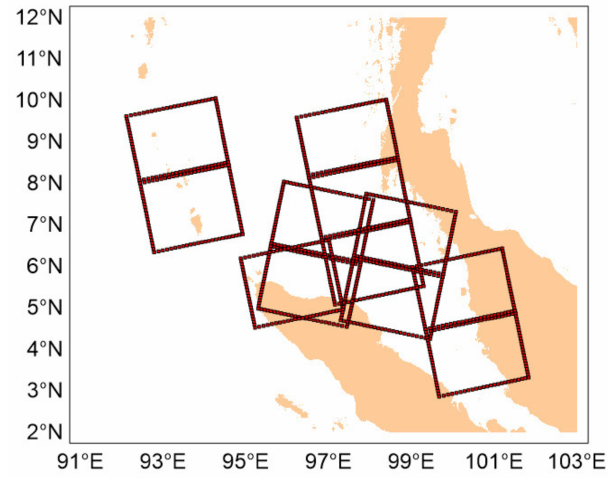
Figure 1. SAR distribution in the Malacca